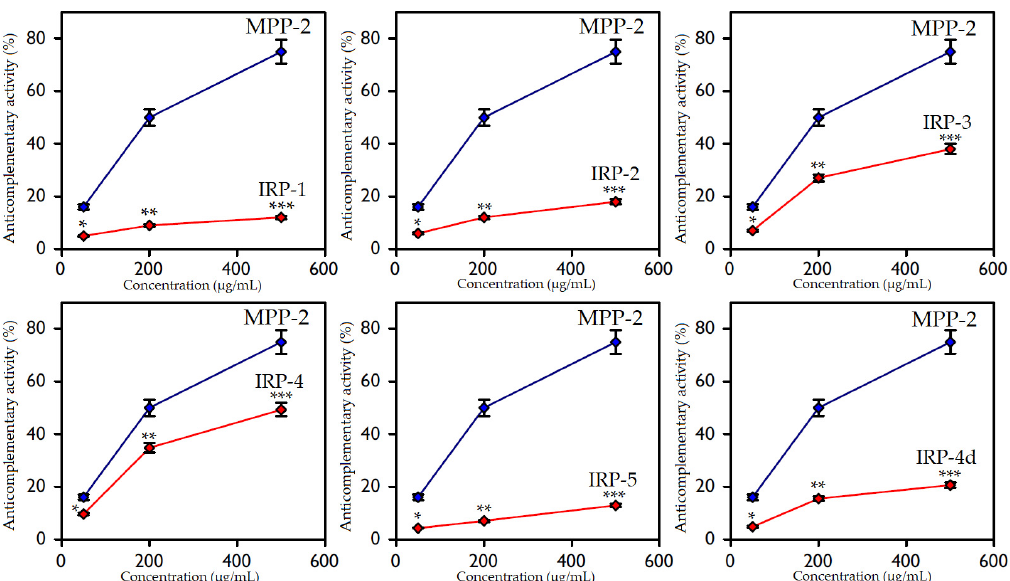
Figure 4. Anticomplementary activity of IRP-1–IRP-5, and IRP-4d polysaccharides. Positive control—MPP-2 polysaccharide from Mentha × piperita . Asterisks indicate significant difference ( p < 0.05) vs. the MPP-2 group, 50 µg/mL (*); vs. the MPP-2 group, 200 µg/mL (**); vs. the MPP-2 group, 500 µg/mL (***).